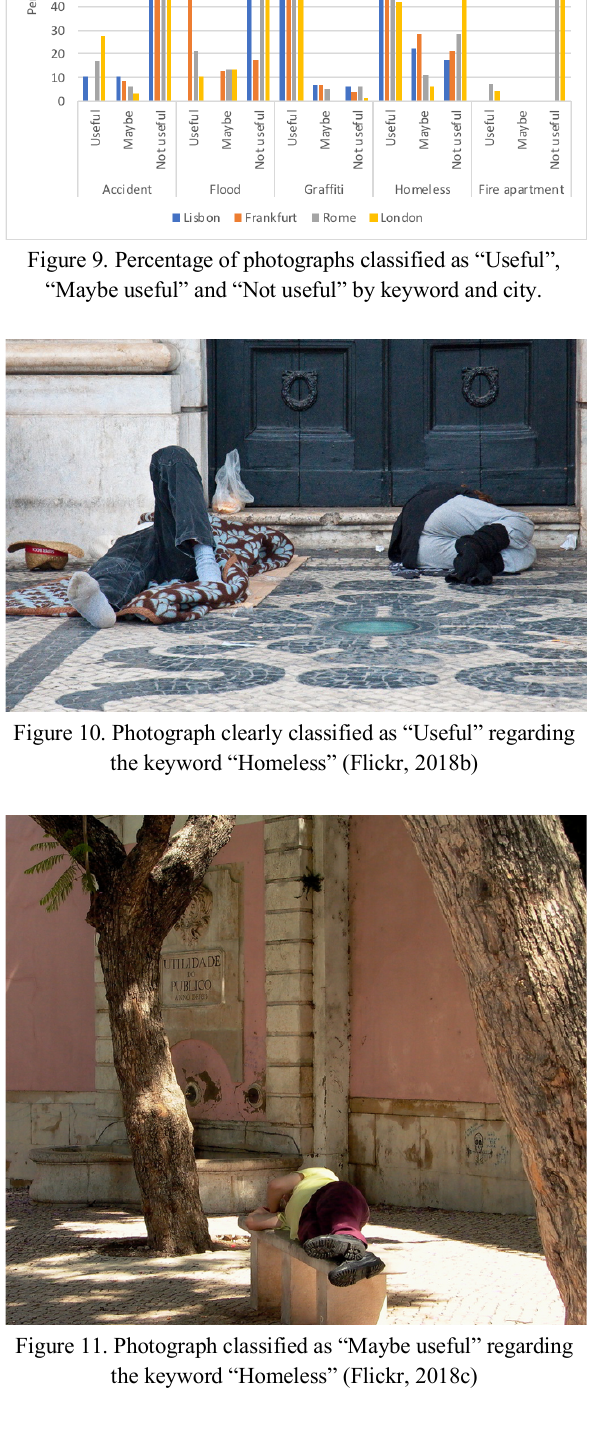
Figure 13. Percentage of posts whose distance (in meters) between their true location and the post location lies within the indicated distance